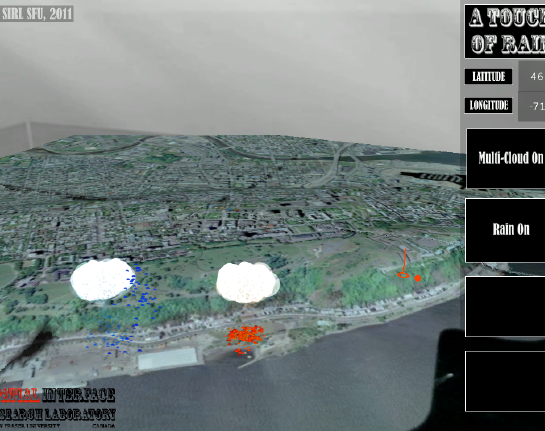
Figure 5. Creating and placing virtual clouds in real space in a location-aware handheld 3D perspective virtual space. (Note red stick indicating user’s location at time of screen capture).